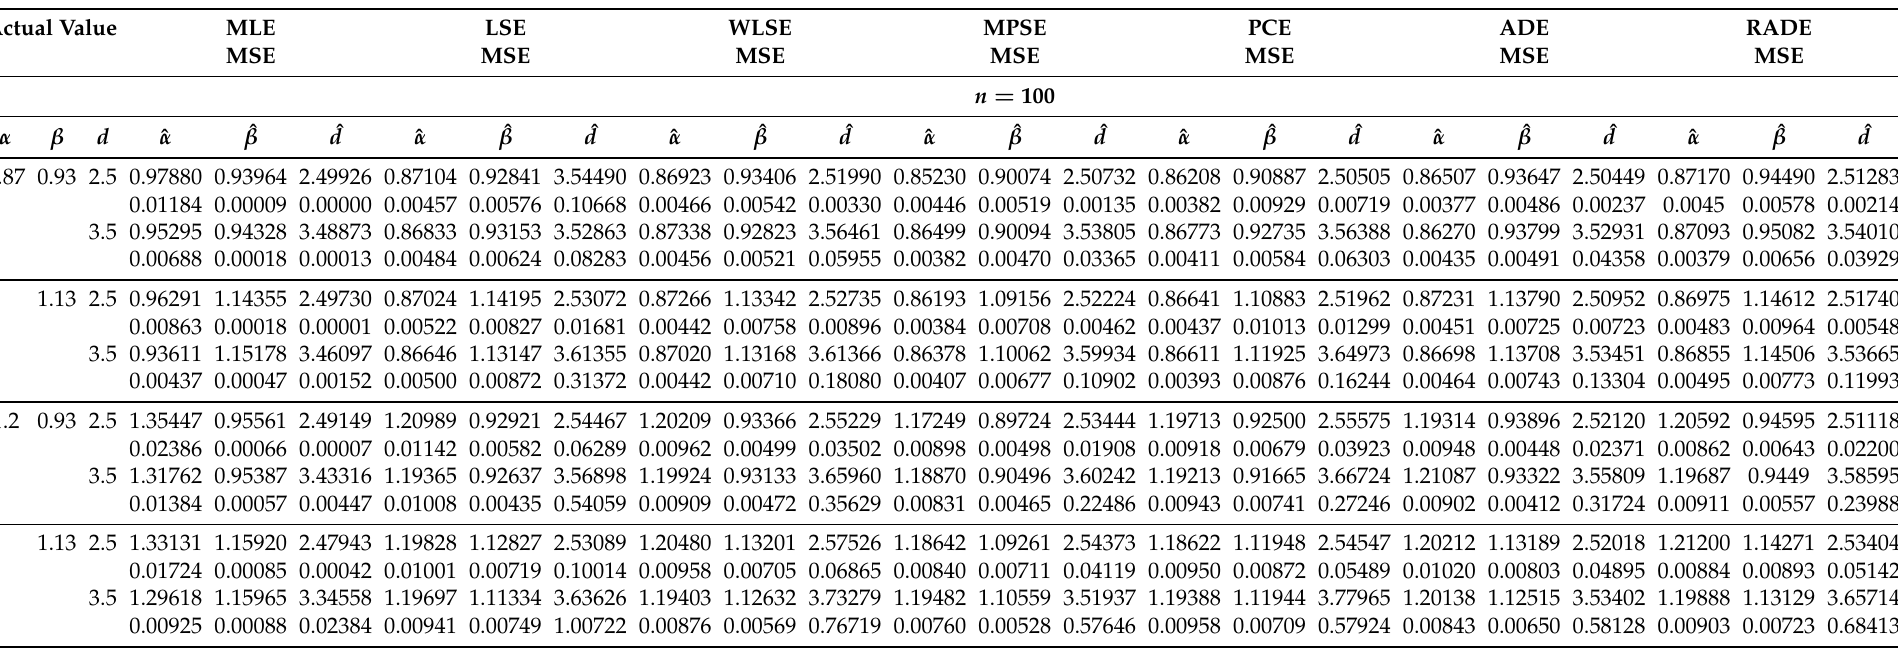
Table 7. The MLEs, LSEs, WLSEs, MPSEs, PCEs, ADEs, RADEs and their